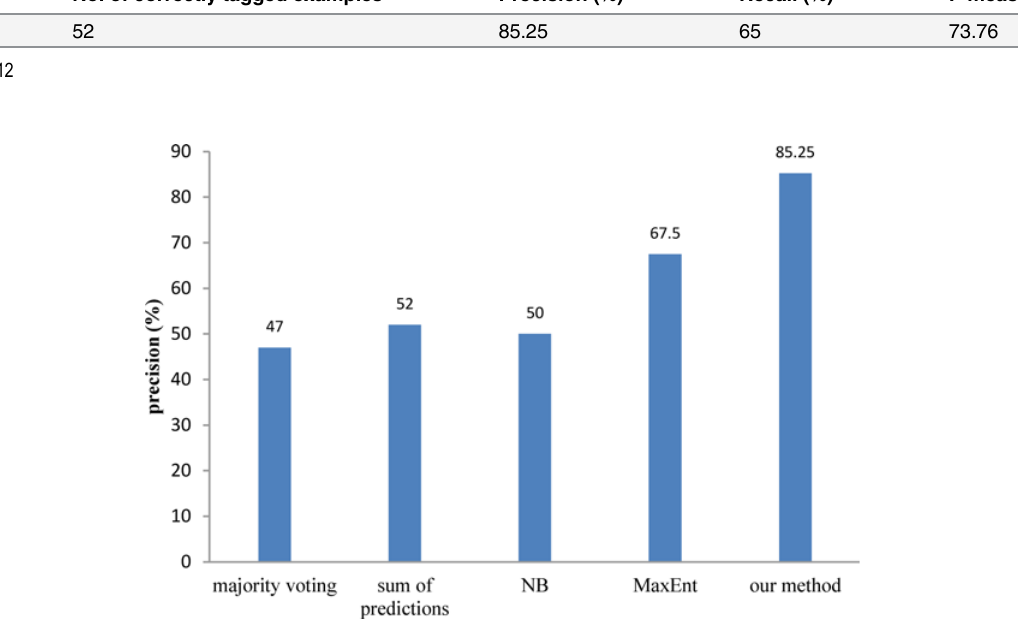
Table 12. Results of polarity detection using OpinionKB No. of tagged examples No. of correctly tagged examples